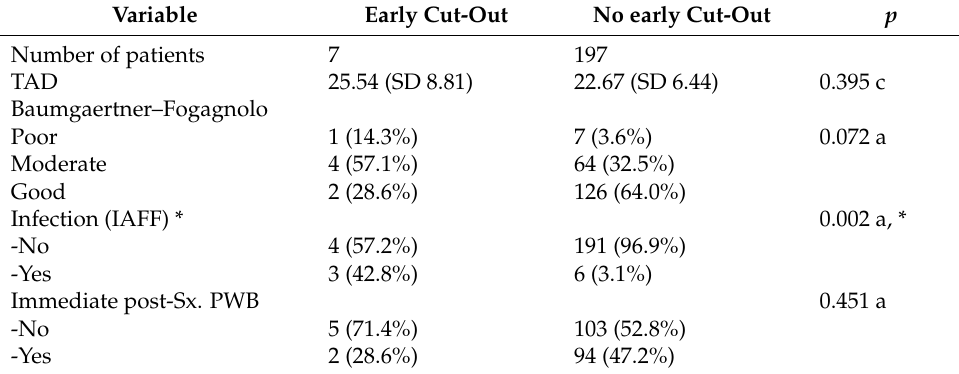
Table 3. Tests: a, Fisher’s exact test; c, Mann–Whitney U test (TAD, tip-to-apex distance; IAFF, infection after fracture fixation; Sx., surgery; PWB, partial weight bearing). *, Statistically